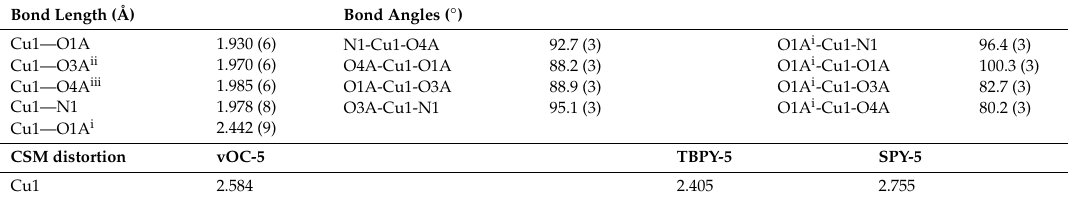
The anhydrous 1.ah shows great differences with respect to the coordination environment of the metal centers in 1 and the arrangement of the ligands. Compound 1.ah crystallizes in the triclinic space group P −1 and its asymmetric unit contains one Cu(II) ion, and half a ligand of each type (Figure S3). The loss of coordination water molecules promotes the formation of a centrosymmetric copper (II) dimer, where each metal center displays a CuNO 4 environment with two bridging carboxylate ligands in a μ 2 -η 1 :η 1 coordination mode, a third bridging carboxylate ligand in a μ 2 -η 2 fashion and N atoms from bpa ligands completing the distorted pentacoordinated geometry. Bond lengths and angles together with the values for CSM are summarized in Table 3. Table 3. Bond lengths and angles for Cu(II) centers in 1.ah , together with the values for CSM. Bond Length (Å)